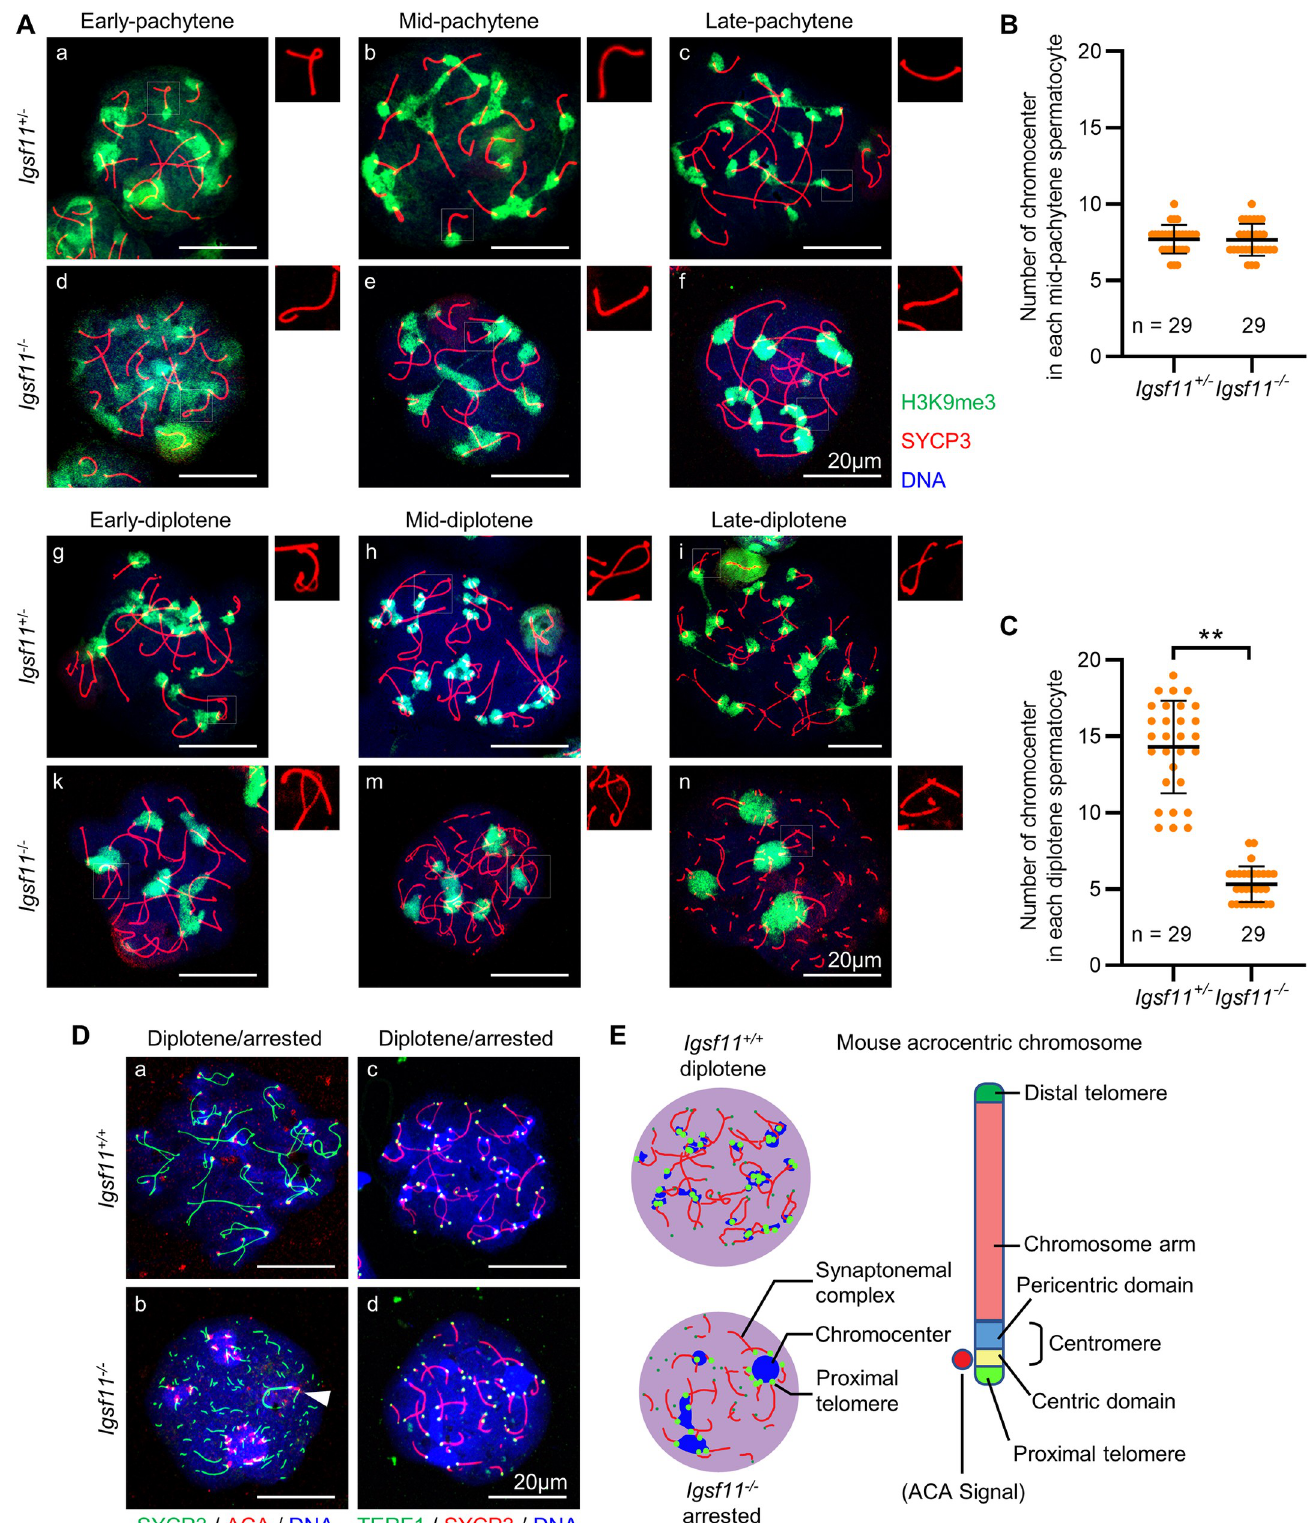
Fig 6. Ig s f11 deficiency compromises nonhomologous pericentric heterochromatin dissociation in mouse primary spermatocytes. (A) Organization dynamic analysis of pericentric heterochromatin during pachytene to diplotene in spermatocytes of the control ( Igsf11 +/- ) and mutant ( Igsf11 -/- ) mice using SYCP3